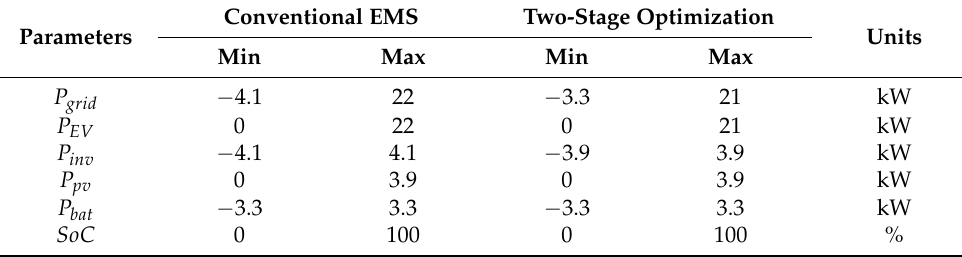
Table 1. Lower and upper limits for the conventional EMS and the two-stage optimization.